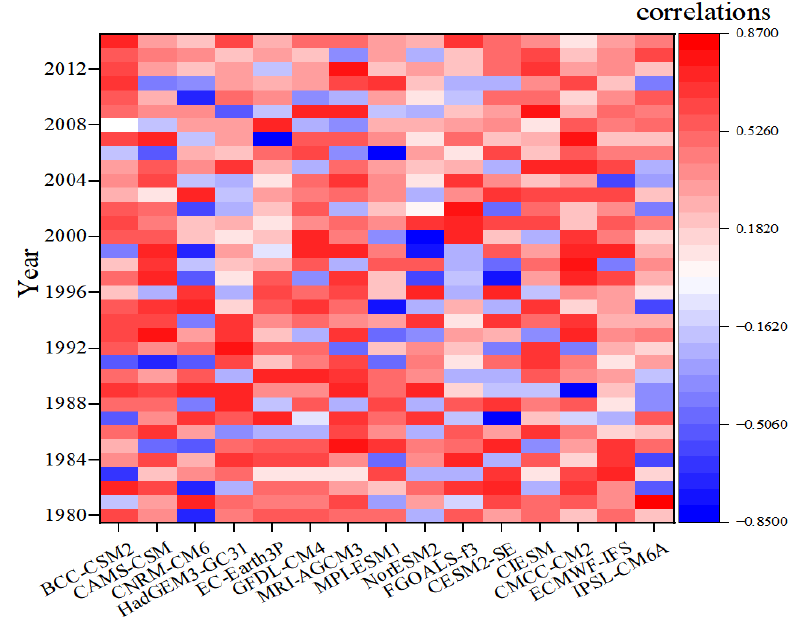
Figure 4. Correlation between the annual mean temperature of each model and the observed data from 1980 to 2014.